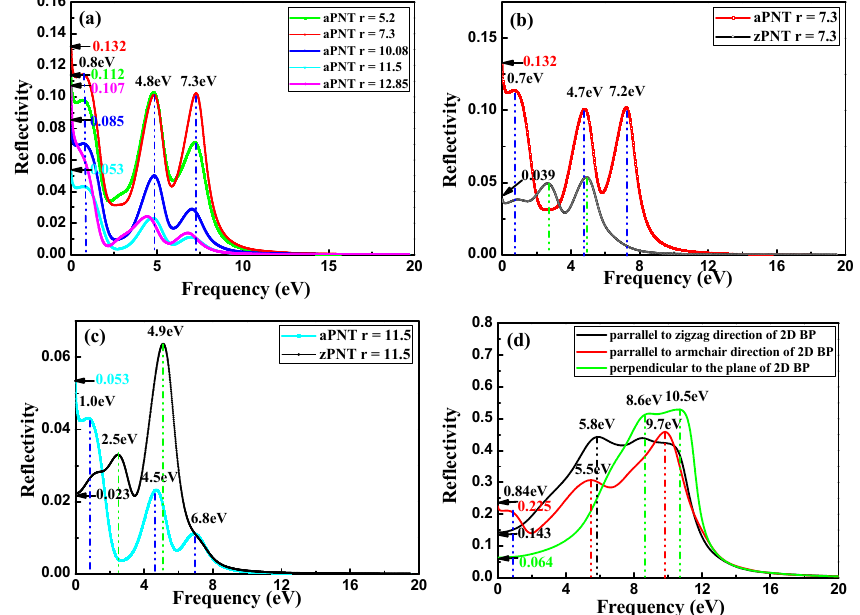
Figure 12. Reflectivity of nanotubes and two-dimensional (2D) BP: ( a ) aPNTs with different radii; ( b ) aPNT and zPNT with the same radius of 7.3 Å; ( c ) aPNT and zPNT with the same radius of 11.5 Å, and ( d ) reflectivity of 2D BP along different polarizations.